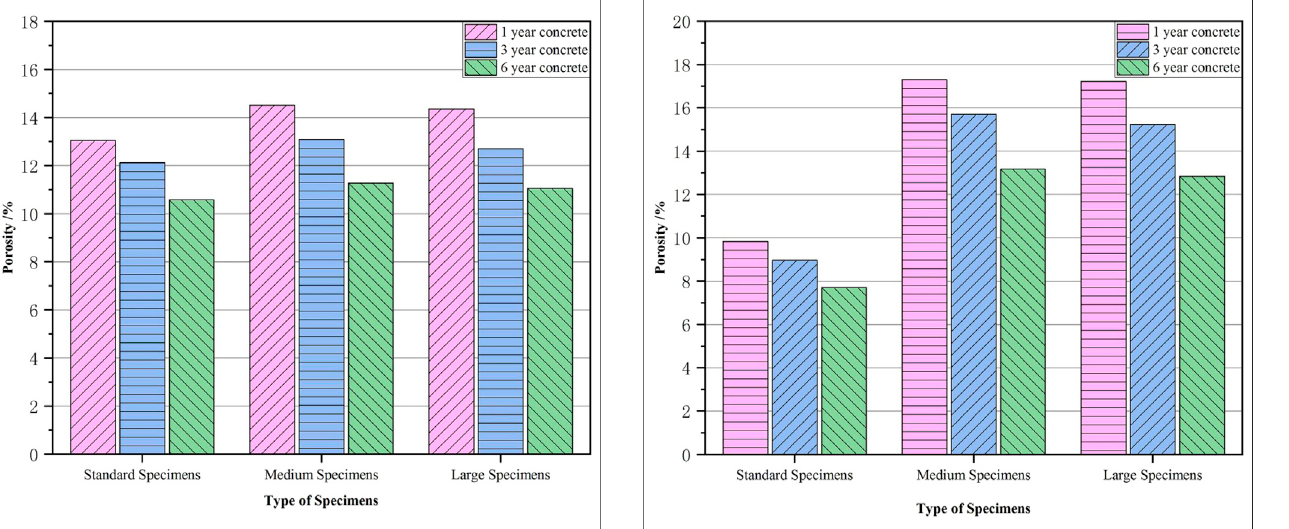
FIGURE 13 | Porosity of the concrete mixed with 6% MgO. FIGURE 14 | Porosity of the concrete mixed with 10%